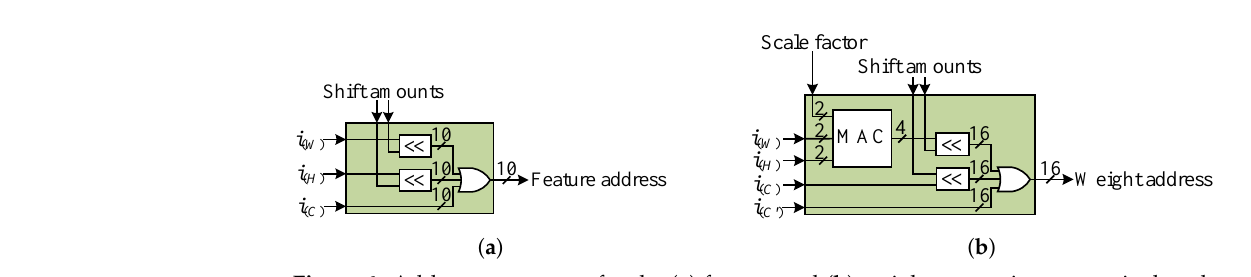
Figure 6. Address generators for the ( a ) feature and ( b ) weight memories, respectively, where (cid:28) stands for a barrel